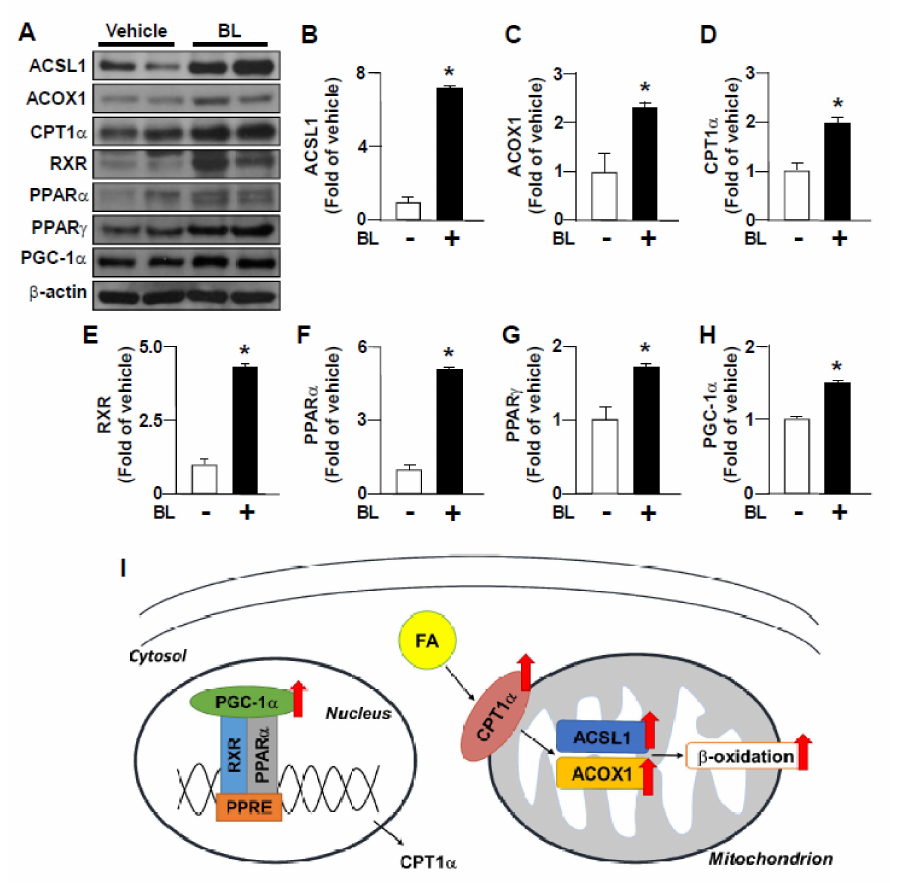
Figure 6. Bromelain increases the expression of FA β -oxidation-related proteins in the liver of HFD-fed mice. Eight-week-old C57BL / 6 mice were fed with HFD and bromelain (20 mg / kg) or vehicle (PBS) for 12 weeks. ( A – H ) Western Blot analysis of protein levels of ACSL1, ACOX1, CPT1 α , retinoid X receptor (RXR), PPAR α , PPAR γ , peroxisome proliferator-activated receptor gamma coactivator 1- α coactivator-1 α (PGC-1 α ) and β -actin. ( I ) The summary for the e ff ect of bromelain on FA metabolism in the liver. The results are presented by the mean ± SEM from 10 mice. * p < 0.05 vs. vehicle group. BL: